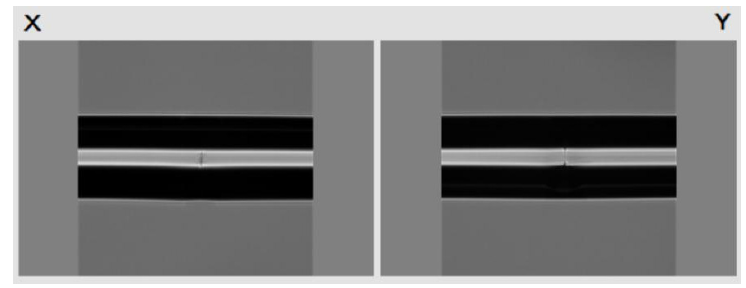
Figure 3. The alignment fusion of MMF-NCF-MMF.